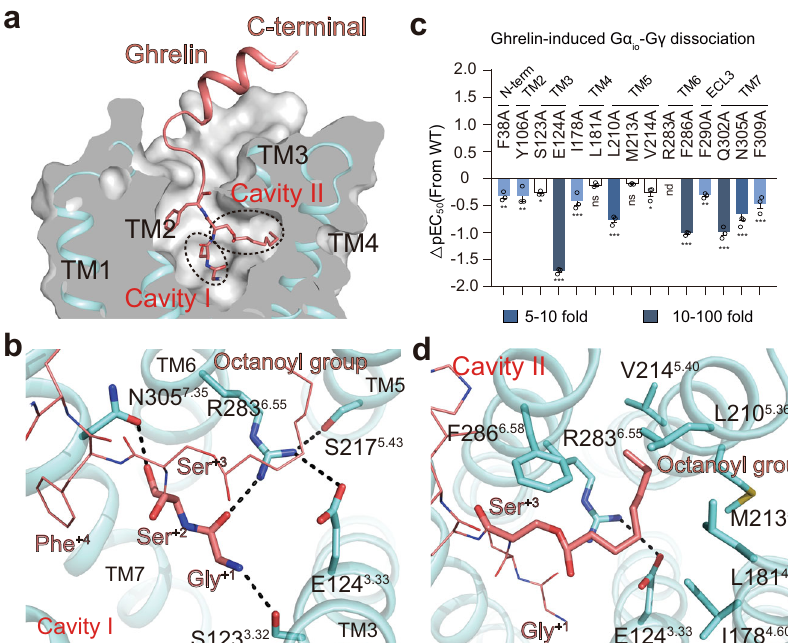
Fig. 3 Recognition of ghrelin by ghrelin receptor. a The cutaway surface of the ghrelin receptor bound to the ghrelin structure reveals that ghrelin occupies the bifurcated ligand-binding pocket with the residues Gly + 1 and Ser + 2 fi lling up cavity I and its octanoyl group of Ser + 3 inserting into cavity II. b Detailed polar interaction of both residues Gly + 1 and Ser + 2 (aquamarine sticks) with the key residues from cavity I. c Ghrelin-induced G α o1-G γ dissociation assay. Bars represent differences in calculated potency (pEC 50 ) of ghrelin for mutations relative to the WT ghrelin receptor. Data are colored according to the extent of the effect. * P < 0.1, ** P < 0.01 and *** P < 0.001. ns no signi fi cant difference, nd not detected. All data were analyzed by one-way analysis of variance (ANOVA) followed by Dunnett ’ s multiple comparison test, compared with the response of WT ( P = 0.002, P = 0.002, P = 0.015, P < 0.001, P < 0.001, P = 0.732, P < 0.001, P = 0.843, P = 0.012, P < 0.001, P = 0.003, P < 0.001, P < 0.001 and P < 0.001 from left to right). Data represent the mean ± SEM from n = 3 biologically independent experiments performed in triplicate. See also Supplementary Figs. 6 and 7. d Detailed interaction of the octanoyl group of Ser + 3 with the key residues from cavity II and salt bridges between E124 3.33 and R283 6.55 are clearly observed in the ghrelin-bound